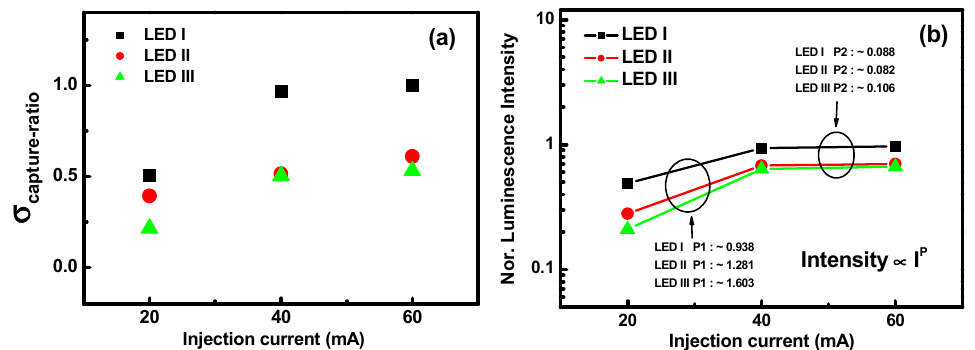
Figure 3. ( a ) The ratio of capture cross-section as a function of the injection current for devices LED I, LED II, and LED III; ( b ) normalized intensity characteristics of samples LED I, LED II, and LED III with different current values at room temperature.